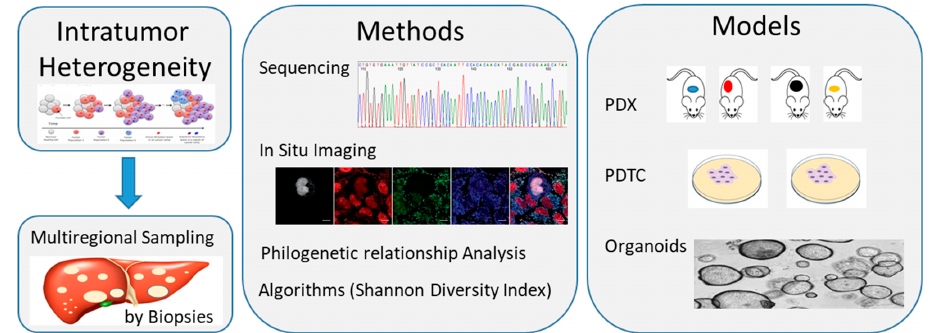
Figure 2. Schematic diagram showing methods and models available to study intratumor heterogeneity of cholangiocar- cinoma (CCA). Multiregional sampling of the tumor through multiple biopsies, followed by single cell and bulk tumor sequencing or in situ imaging, can allow to catch the compositional subclones within each tumor. Data can be quantified by diverse algorithms, like the Shannon Diversity Index, and categorized by using Phylogenetic relationship analysis. Preclinical studies on in vivo tumor xenograft and in vitro cell cultures (cell layers or spheroids/organoids) models could allow us to recapture and maintain the compositional heterogeneity within a tumor and use it for drug screening. PDTC, patient-derived tumor cell; PDX, patient-derived tumor xenograft.